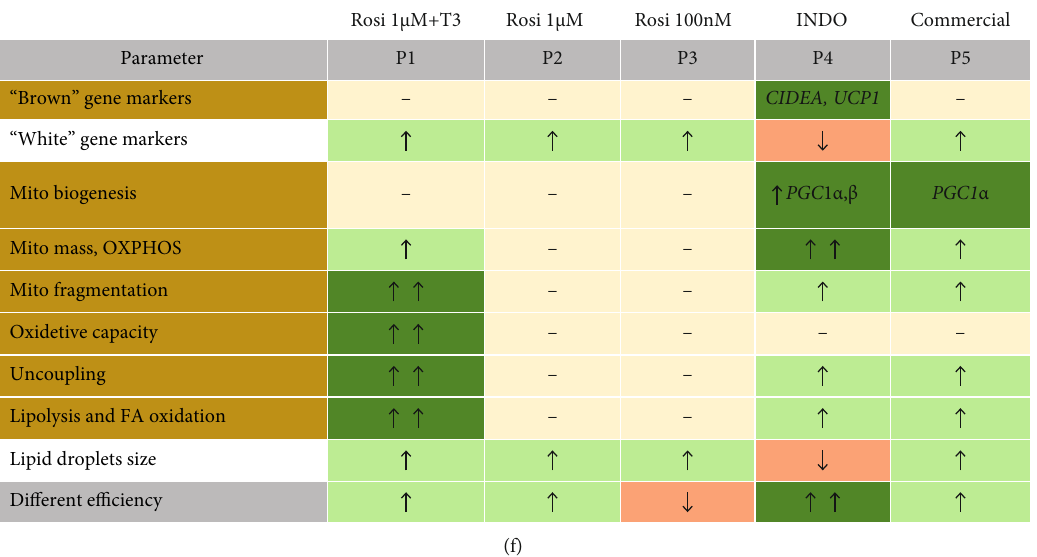
Figure 6: Expression levels of mitochondrial biogenesis and mtDNA-encoded genes. Human adipose-derived stem cells were di ff erentiated for 21 days with fi ve adipogenic di ff erentiation protocols. Relative mRNA expression of nuclear-encoded genes (a) PGC1 α and (b) PGC1 β measured by RT-qPCR. (c) Relative mRNA expression of PGC1 α in in vitro -di ff erentiated adipocytes, white adipose tissue (WAT), and mature adipocyte fraction (MAF) of the same subjects measured by RT-qPCR. Relative mRNA expression of mitochondrial-encoded genes (d) MT-COXI and (e) MT-ND5 measured by RT-qPCR. Statistical analysis was performed using one-way ANOVA ( n = 6 ) followed by Tukey ’ s post hoc analysis: ∗ p < 0 : 05 , ∗∗ p < 0 : 01 , and ∗∗∗ p < 0 : 001 . Error bars are shown as SEM. (f) Summary